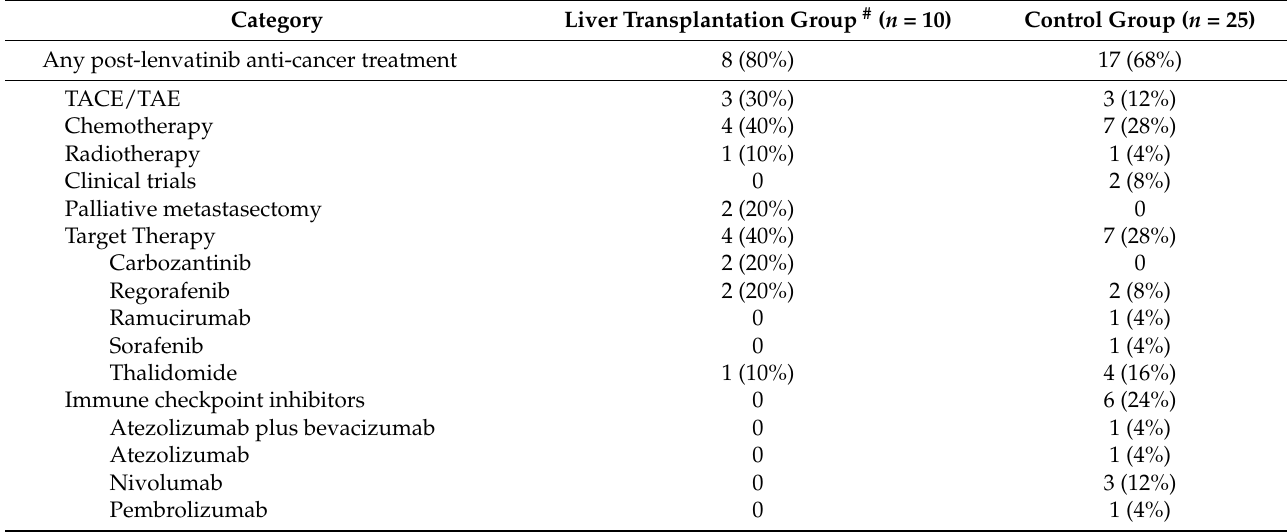
Table 3. Post-lenvatinib anti-cancer therapy in the 35 patients with unresectable hepatocellular carcinoma. Category Liver Transplantation Group # ( n = 10) Control Group ( n = 25)